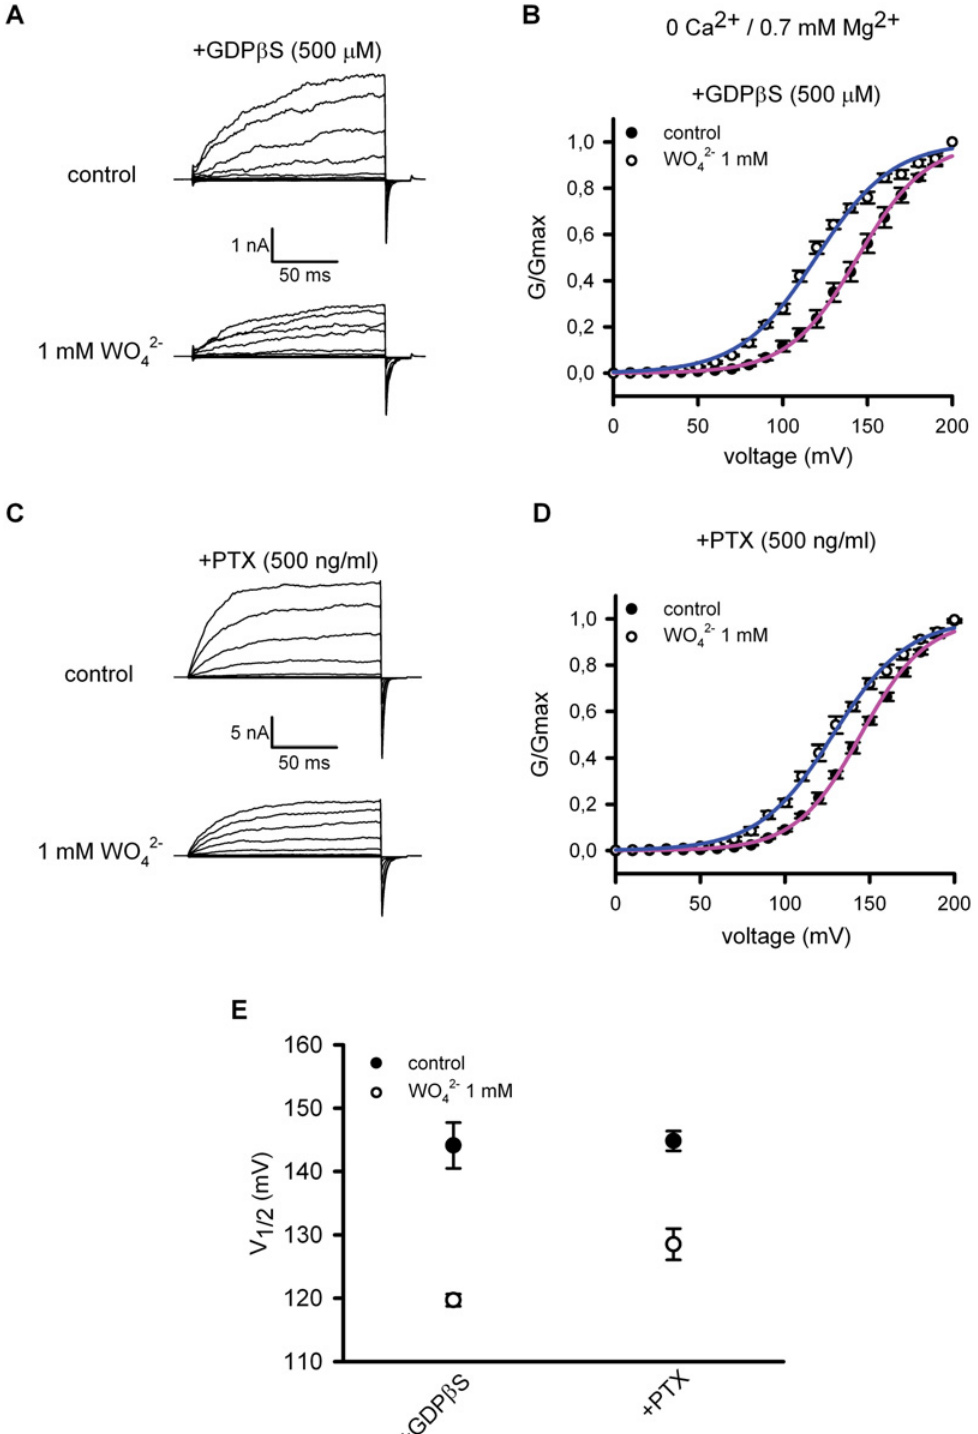
Fig 2. Tungstate-mediated activation of BK αβ 1 channels is independent of G proteins. Representative currents recorded from excised inside-out macropatches obtained from HEK293 cells expressing the BK αβ 1 channels in the presence of 500 μ M GDP β S (added to the bath solution) (A) or from transfected HEK293 cells pre-incubated with PTX (500 ng/ml, 24 hours) (C). Currents were recorded at cytosolic 0 Ca 2+ and 0.7 mM Mg 2+ before (control, top panels) and 5 – 10 minutes after cytosolic application of 1 mM tungstate (WO 42- , bottom panel). The voltage protocol was as described in the Methods. (B), (D) Average G-V curves for BK αβ 1 channels under the experimental conditions above mentioned. Solid curves were obtained by fitting the normalized